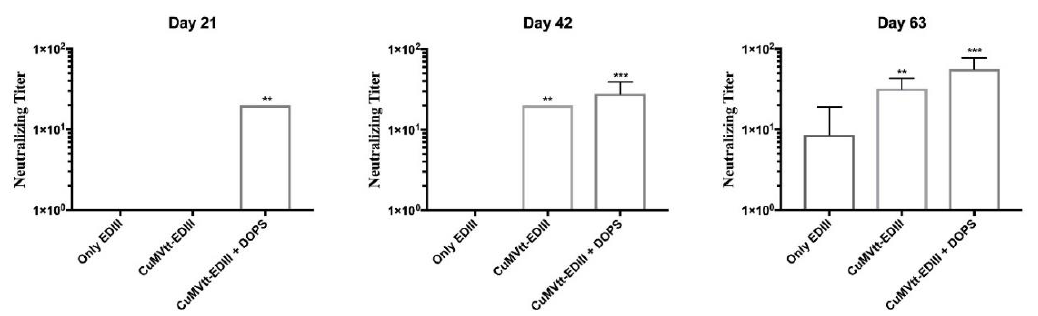
Figure 5. ZIKV neutralising capacity assessment. The figure shows the titer of ZIKV-neutralising antibodies that was evaluated in sera of mice vaccinated with only EDIII protein, CuMVtt-EDIII and CuMVtt-EDIII plus DOPS. The data shown here are from samples collected on days 21, 42 and 63 and two independent experiments were performed. Note: ** p < 0.001, *** p < 0.0001.